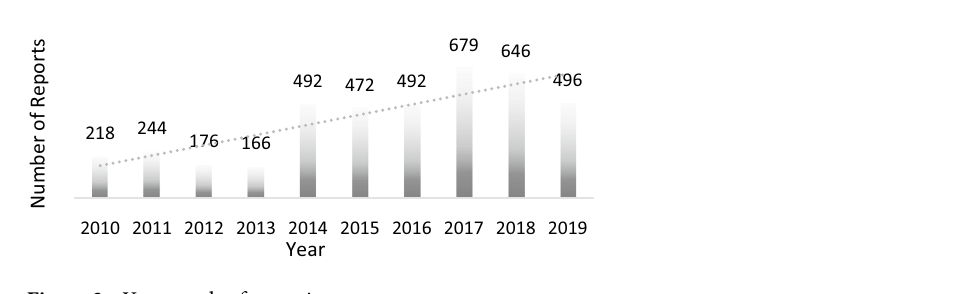
Figure 2. Year trends of